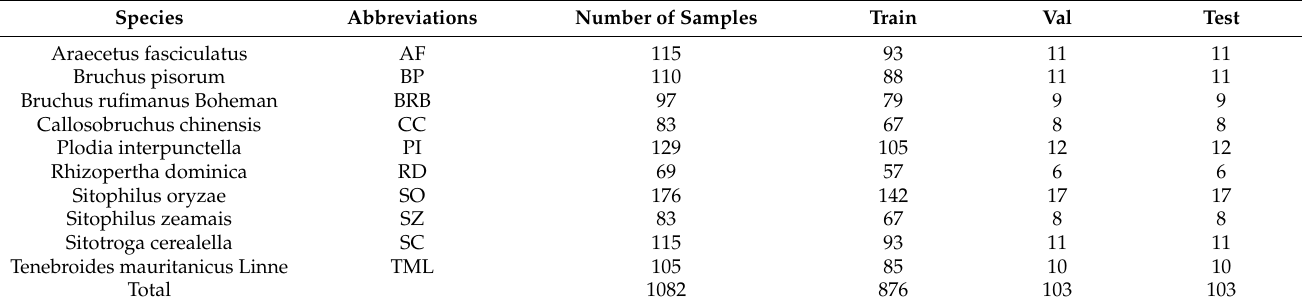
Table 2. Composition of the D0